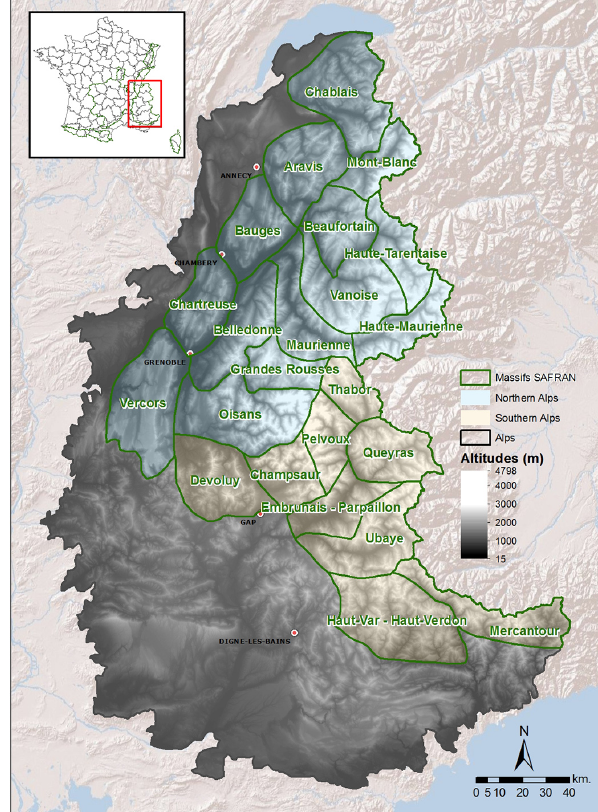
Figure 1. Area studied. Within the SAFRAN model, the French Alps are divided into 23 massifs (source: H. François, IRSTEA, In- stitut de recherche en sciences et technologies pour l’environnement et